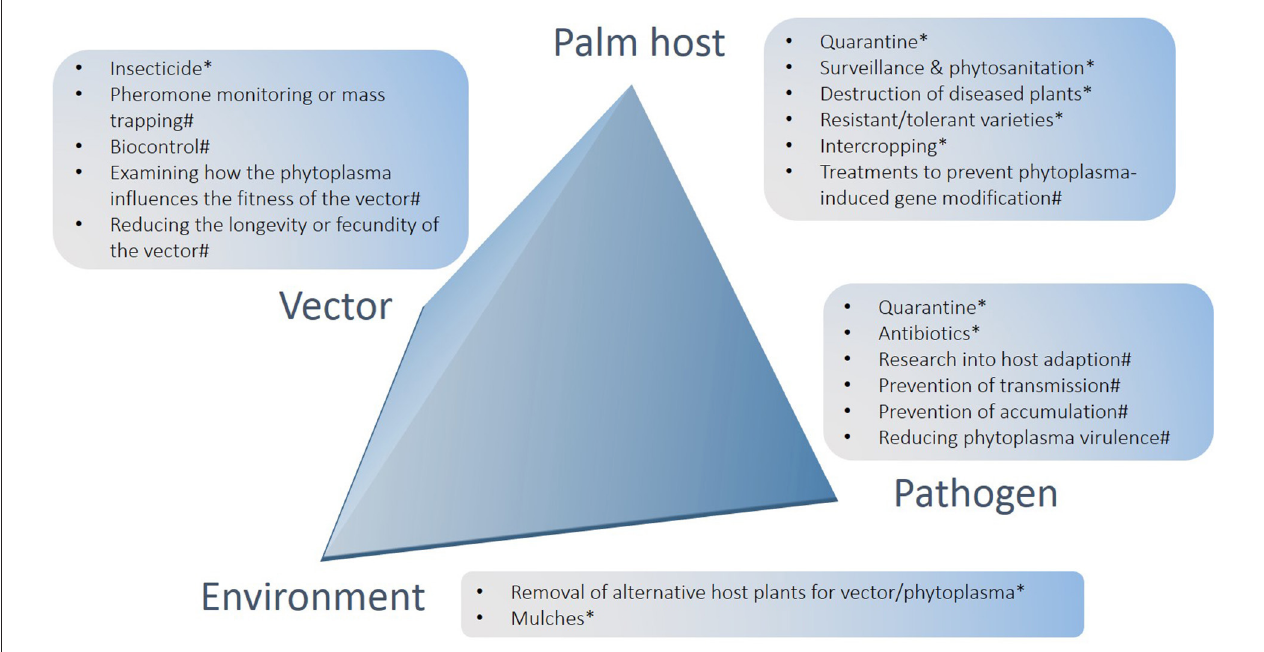
FIGURE 2 | Summary of options for the management of lethal yellowing diseases of palms arranged in relation to crop, pathogen, environment and vector components of the pathosystem. *Denotes options that have had impact in at least some field settings, including methods that have scope for further development and use; # denotes potential future